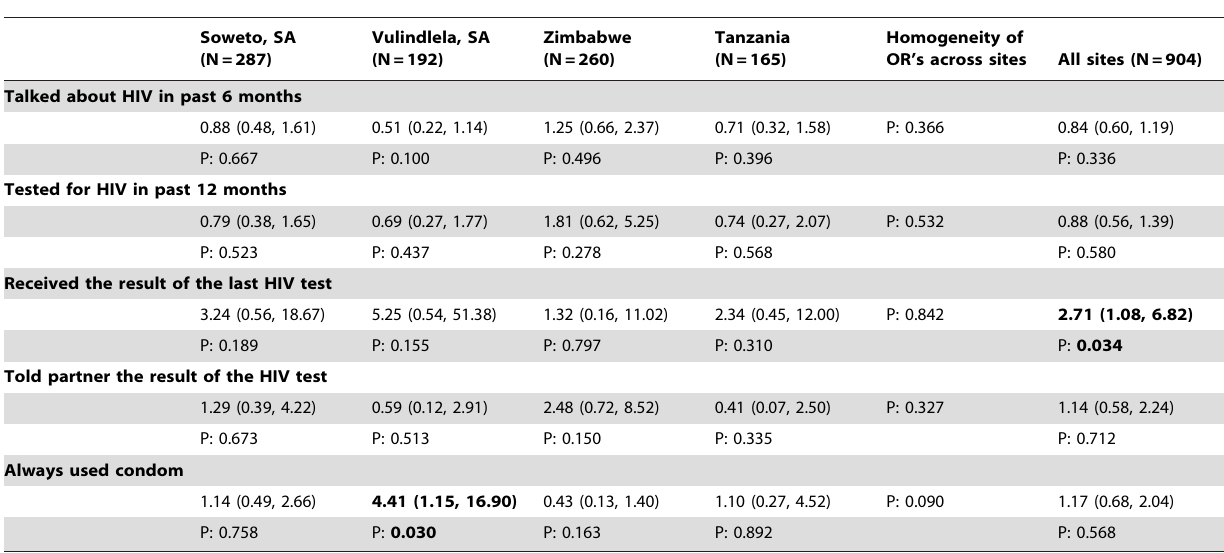
Table 3. Effect of intervention on preventive behavior among CSA or CPA